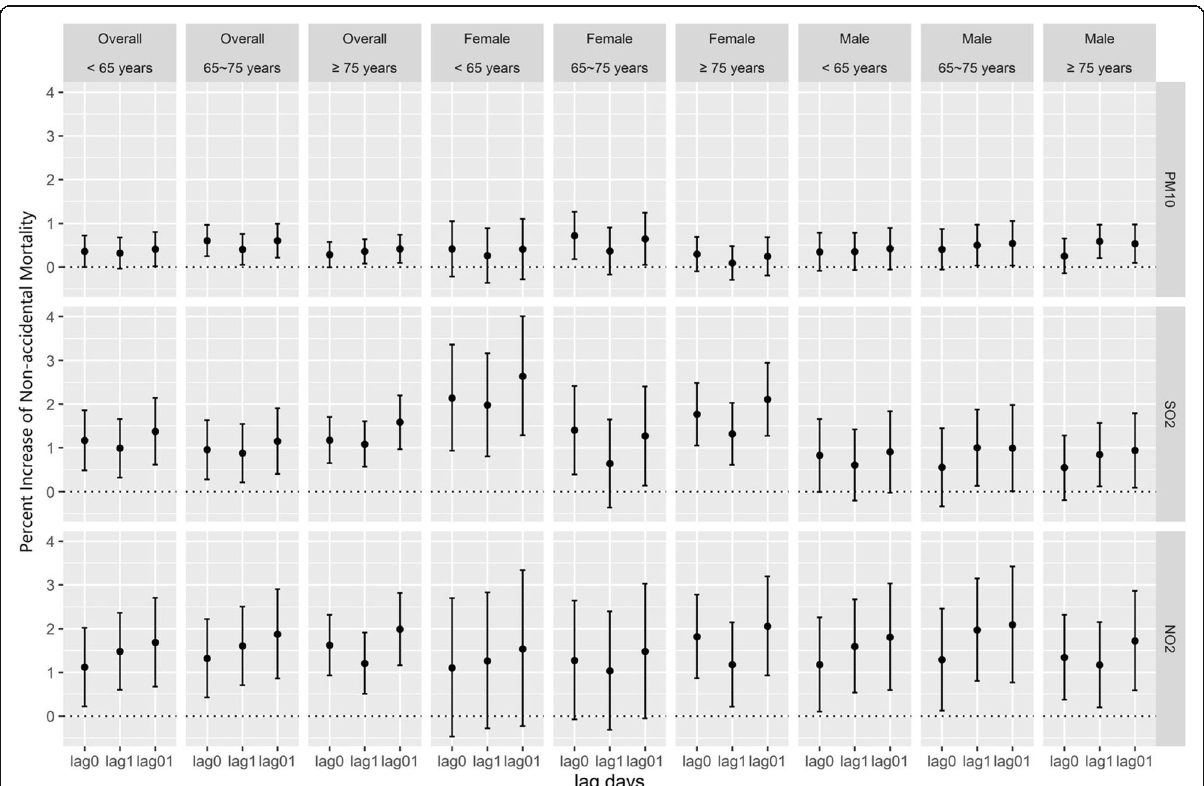
Fig. 2 Effect estimates of age categories and age categories for each sex on non-accidental mortality at lag0, lag1, and lag01 for three